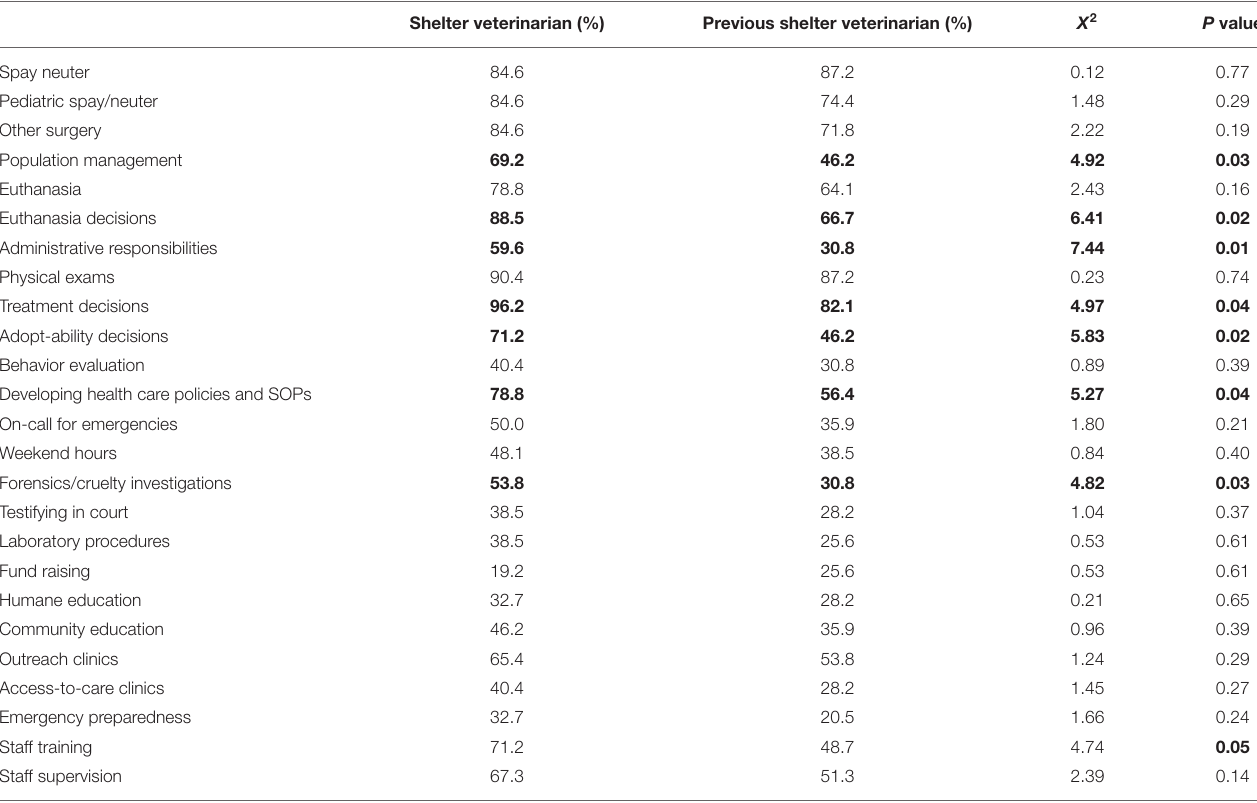
TABLE 3 | Frequency of common duties of shelter medicine among current and previous shelter veterinarians. Shelter veterinarian